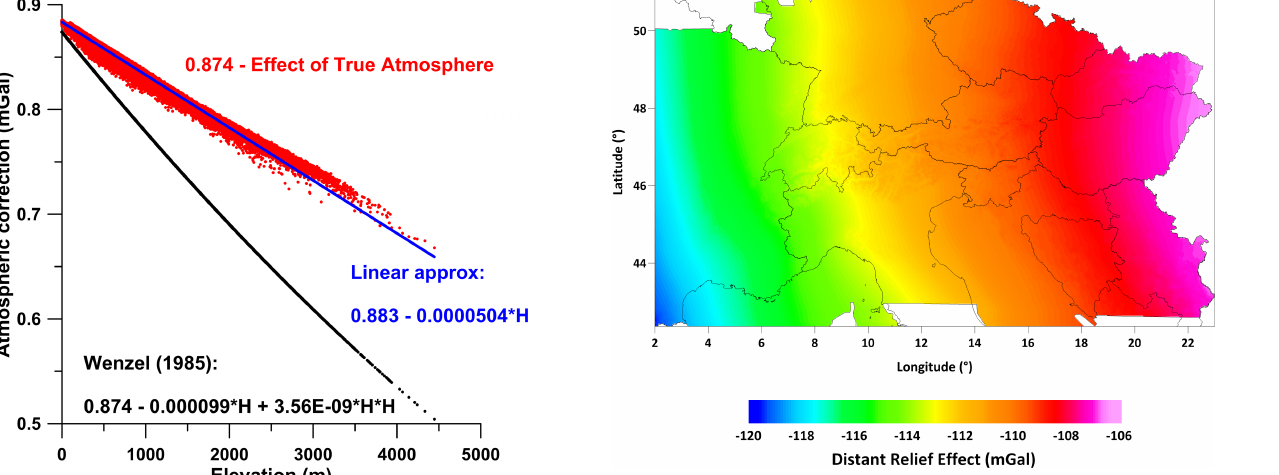
Figure 9. Comparison of atmospheric correction at selected points covering the whole AlpArray area. The black dots represent the at- mospheric correction calculated by a simple approximation accord- ing to Wenzel (1985). The red dots show the calculation using the effect of true atmosphere subtracted from the global constant value of 0.874mGal (Mikuška et al., 2008), and the blue line is its linear approximation.